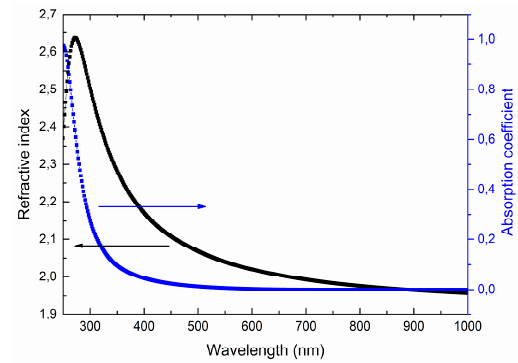
Figure 10. Spectral dependences of refractive index n and absorption coefficient k on a wavelength for the LiNbO 3 films grown at oxygen pressure 1 × 10 − 2 Torr.